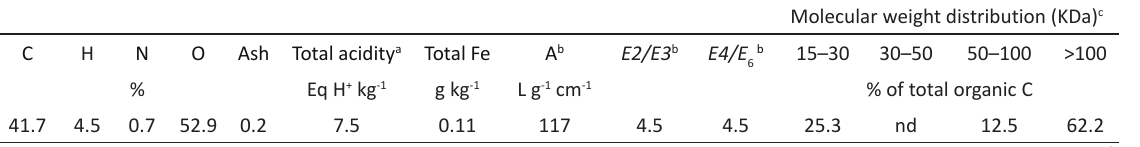
Table 1. Characteristics of humic substances used in the